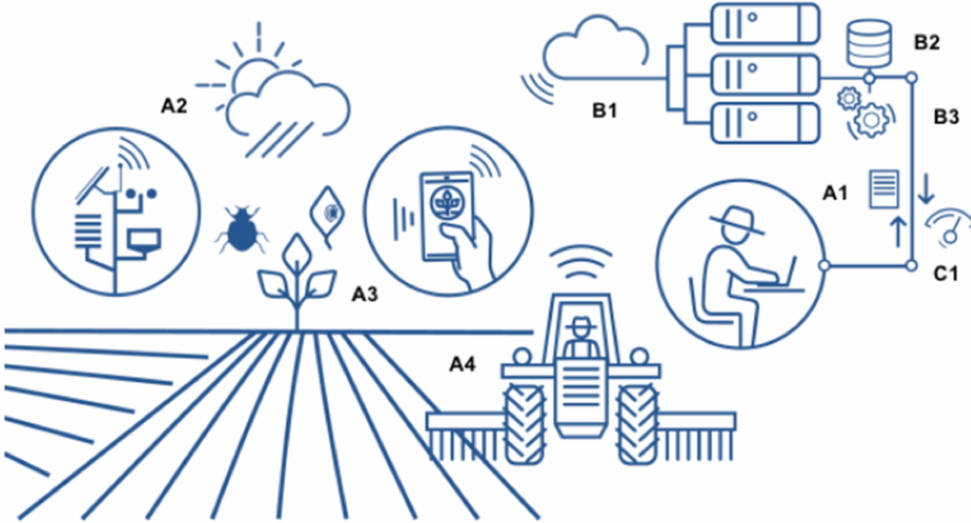
Figure 2. Scheme of a modern decision support system based on a forecasting model for plant disease management. Information about crop-specific characteristics ( A1 ), environmental conditions ( A2 ), crop and plant status ( A3 ), and agricultural operations ( A4 ) flows from the crop to a remote server ( B1 ), and it is stored in database ( B2 ). This information is then used as an input for running mathematical models and decision algorithms ( B3 ), which generate decision supports and alerts to the grower for deciding when and how apply a protective agent ( C1 ). (Reproduced from